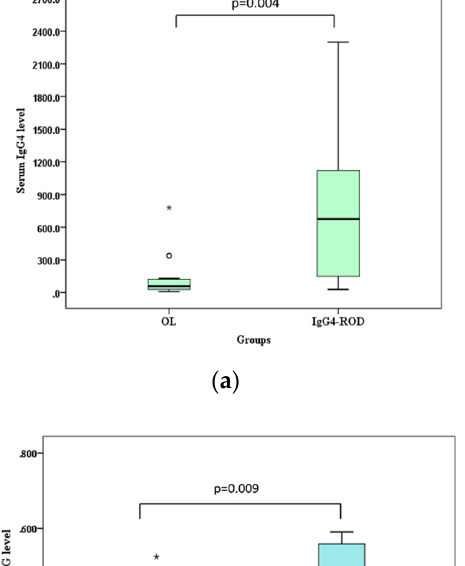
Table 4. The descriptive statistical prebiopsy values of serum IgG4 levels (serum IgG4), serum immunoglobulin G (IgG) levels (serum IgG) and the ratios of serum IgG4 level/serum IgG level (serum IgG4/IgG) of the 16 patients with orbital lymphoma and the 9 patients with IgG4-ROD.